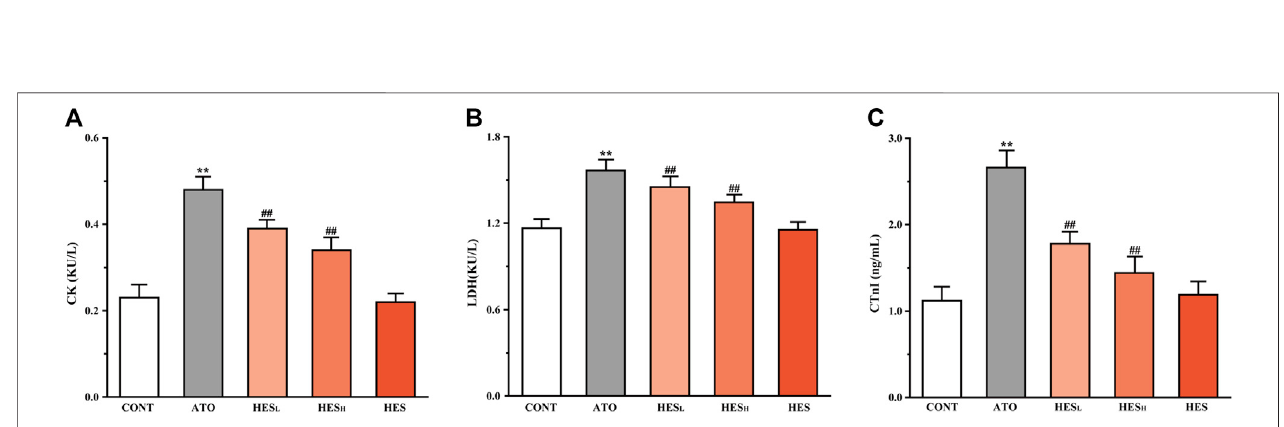
FIGURE3 | Changesin CK (A) , LDH (B) and cTnI (C) expression are shown between ATOgroup and HES treatmentgroups. Values are expressed asmean ± SD ( n (cid:1) 6). Compared with CONT group (** p < 0.01), compared with ATO group ( # p < 0.05, ## p < 0.01).